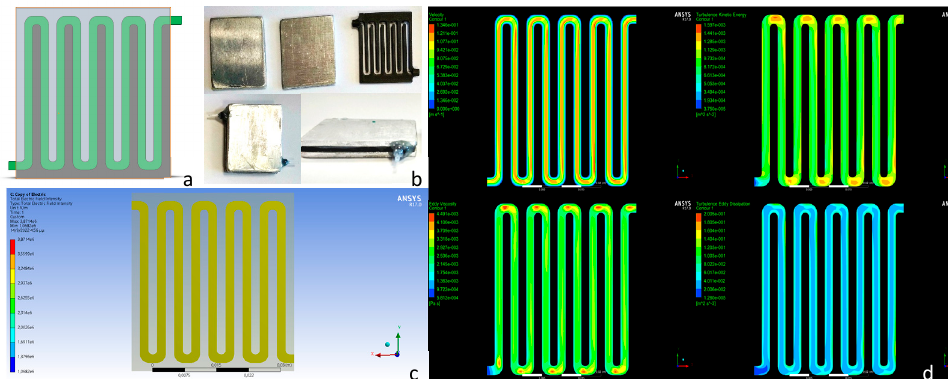
Figure 2. ( a ) Electroporation chamber with smoothed corners. ( b ) Channels’ chamber system that was used to fabricate the continuous electroporation apparatus. Metallic plates were glued to the two plastic structures. ( c ) Electric field intensity distributed in the chamber. ( d ) Fluid flow characteristics inside the chamber with smooth turns.